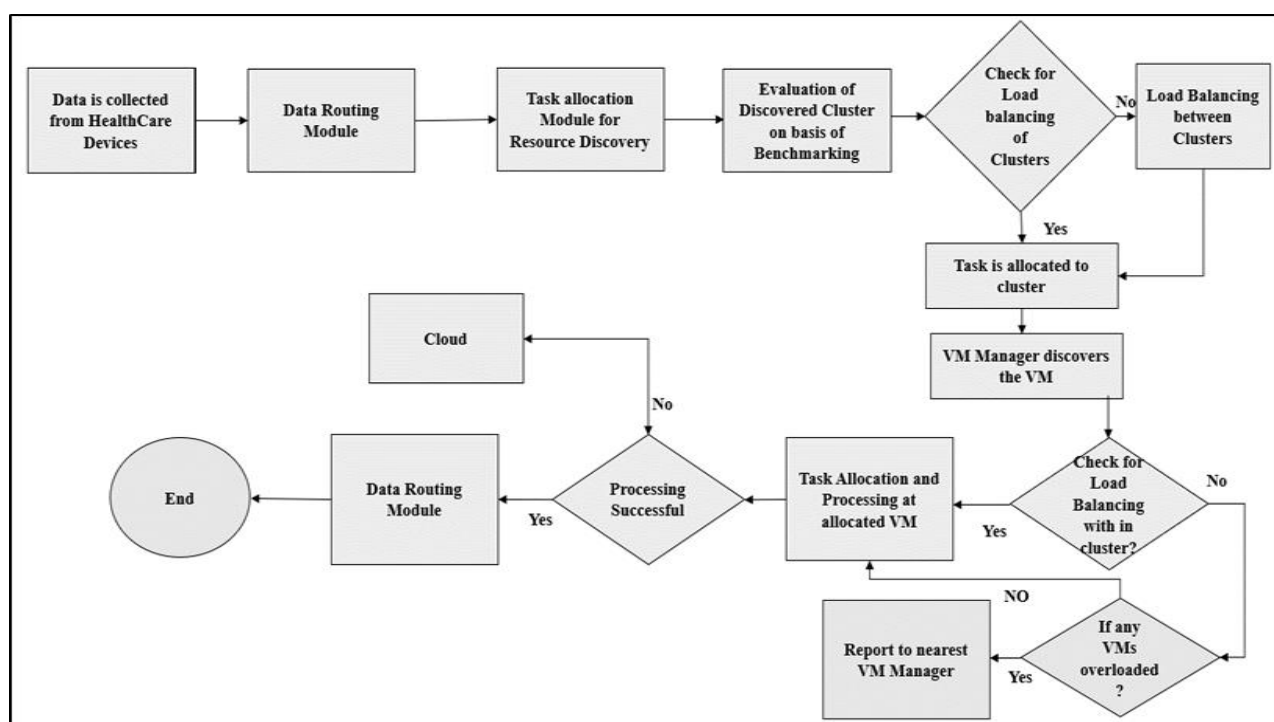
Figure 8. Work flow of the proposed framework